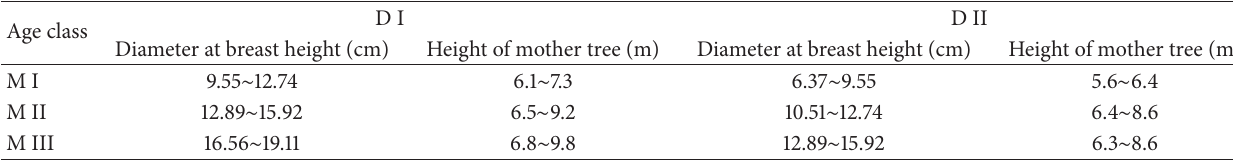
Table 1: Mother tree characteristics of Pinus thunbergii for collecting cones and